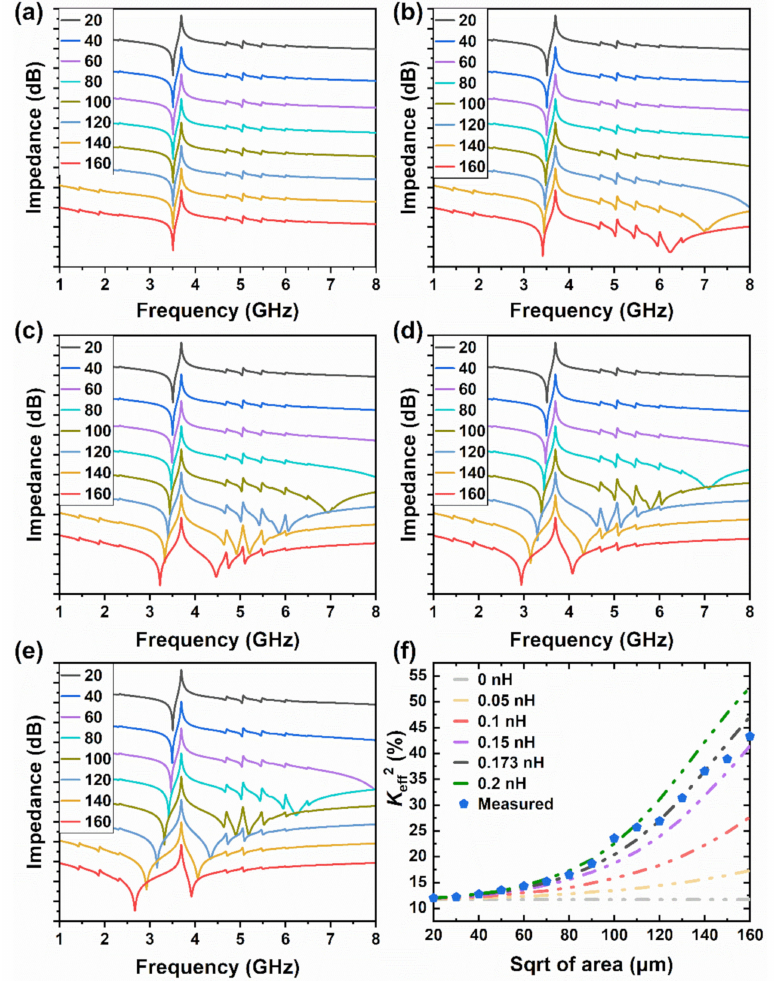
Figure 9. The square of the area is used to characterize the resonant area of resonators. ( a – e ) Simulated impedance curves of resonators with inductance in series by the Mason model. ( a ) L S = 0 nH; ( b ) L S = 0.05 nH; ( c ) L S = 0.1 nH; ( d ) L S = 0.15 nH; ( e ) L S = 0.2 nH; ( f ) Simulated and measured K eff2 with different resonant areas, in which the double dash dot lines are the simulated